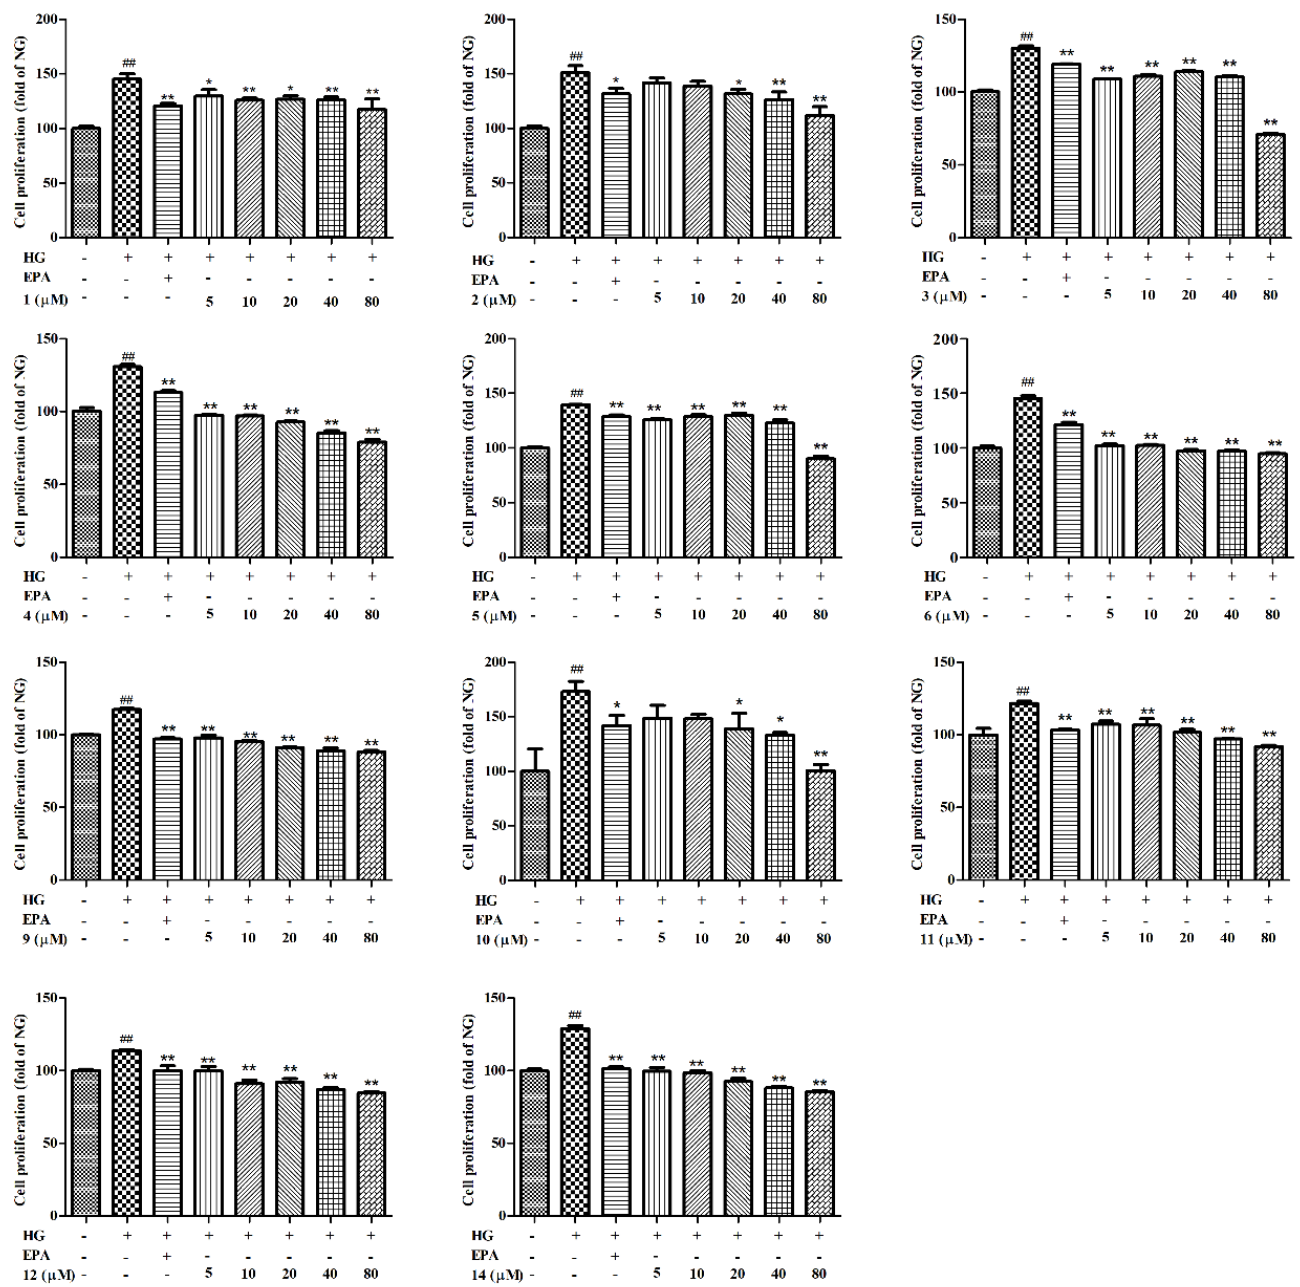
Figure 4. Cell proliferation in GMCs was detected with MTT assay with various concentrations of 1 – 6 , 9 – 12 , and 14 (5, 10, 20, 40, 80 µ M) for 48 h. Values are expressed as mean ± SD of three independent experiments, with ## p < 0.05 relative to the NG and * p < 0.05 or ** p < 0.01 relative to the HG group.